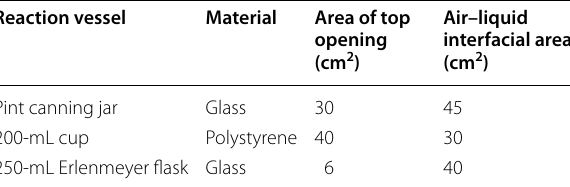
Table 2 Reaction vessel characteristics in study of impact of air (O ) on reaction rate 2 Reaction